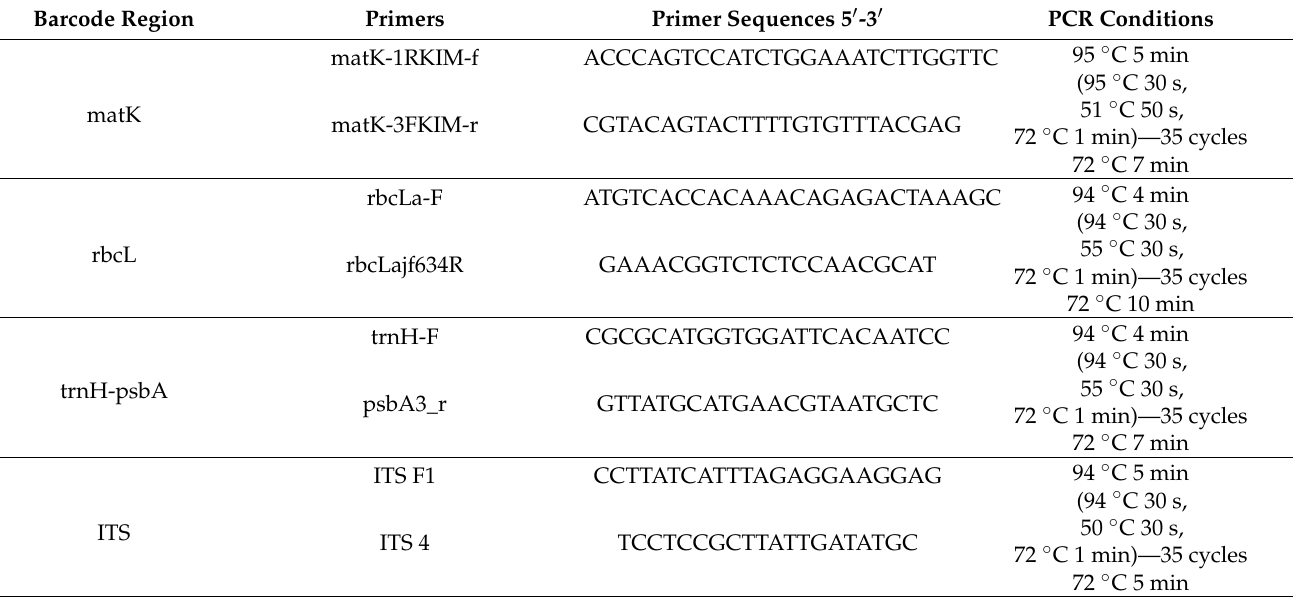
Table 3. Oligonucleotide primers used for amplification of DNA barcode regions, and the respective PCR